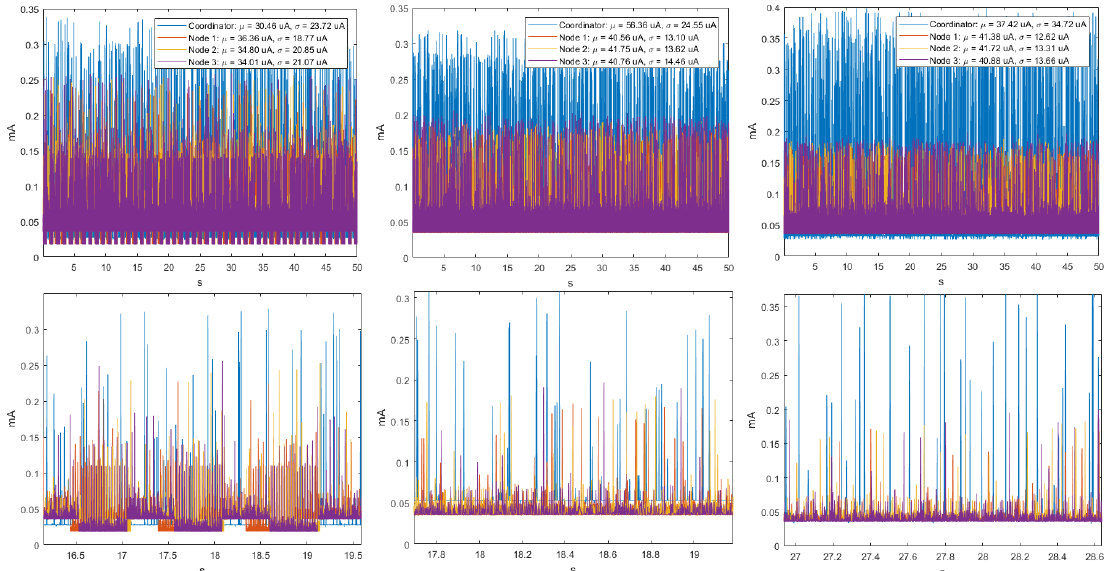
Figure 8. Time signals for ZigBee network. From left to right: at 9600, 19,200, and 57,600 bauds. ( Top ) Complete time signal; and ( Bottom ) time detail of the same signal.